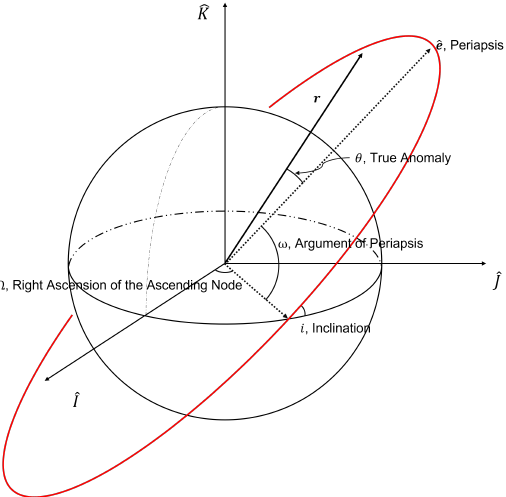
Figure 2. Geometry classical orbital elements.